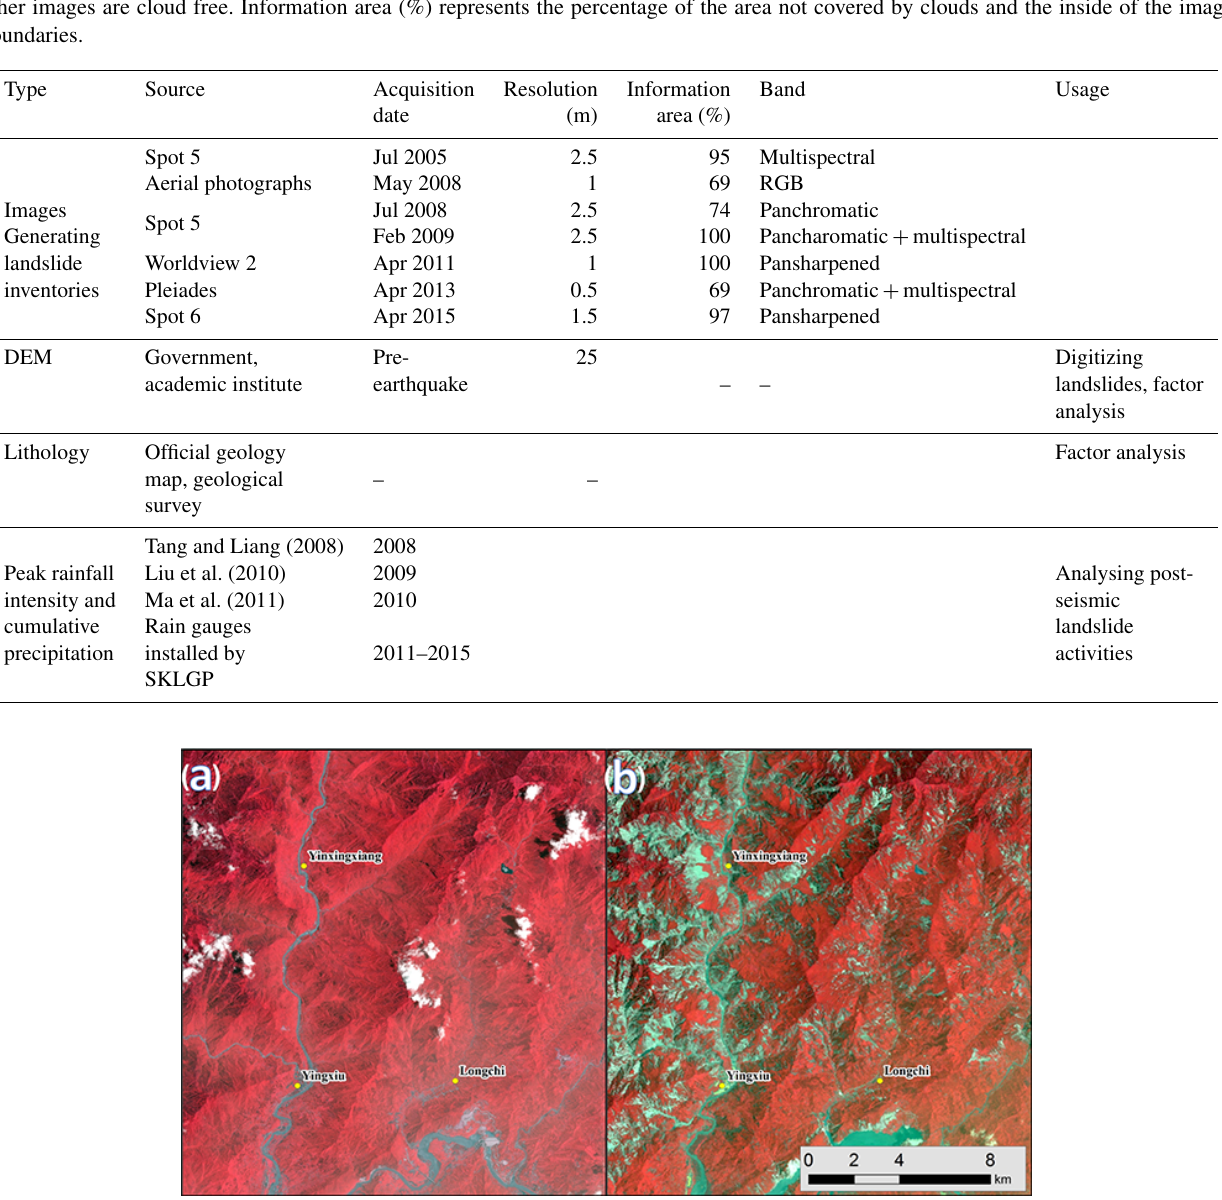
Figure 2. False colour satellite images before (a) and after (b) the earthquake, showing the large extent of forested areas before the earthquake and the numerous slopes lacking vegetation due to landslides in the post-earthquake